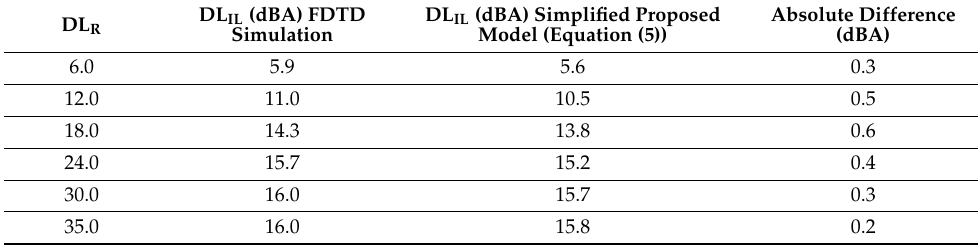
Table 1. Comparison of the values of global IL ( DL IL ) obtained from the FDTD numerical simulation and the simple model proposed in this work (Equation (5)) for different values of the airborne sound insulation ( DL R ). The absolute differences are always below a JND (1